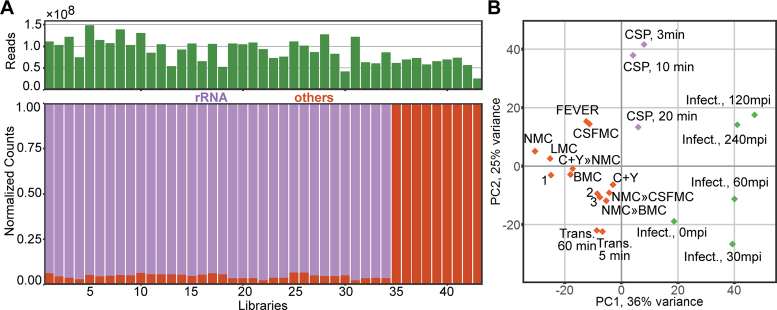
Distribution of libraries and conditions. (A) The number of trimmed reads of the 43 libraries ranged from 26 to 149 million reads, averaging 89 million reads. Non-rRNA-depleted libraries were dominated by reads mapped to ribosomal RNA genes, averaging 95% (range: 93–98%, libs. 1–34). (B) Principal component analysis of gene expression in all conditions showed three clusters of conditions: conditions based on competence (CSP, 3, 10 and 20 min; purple), epithelial infection (infection 0, 30, 60, 120 and 240 mpi; green) and other infection-relevant conditions (orange). 1 = Transmission » NMC; 2 = NMC » LMC; 3 = BMC » C+Y.